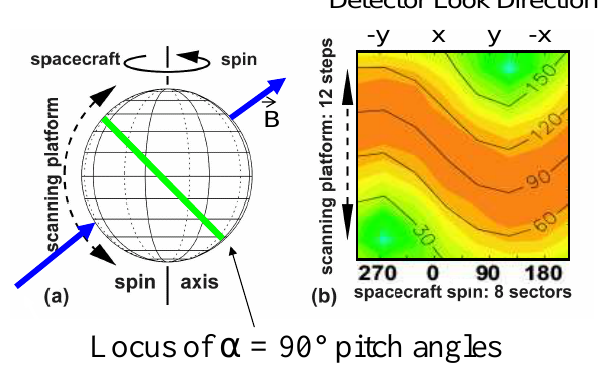
Fig. 2. This figure demonstrates how one interprets Figs. 3–5. The detector scans through the unit sphere in 36s (left) and the fluxes are linearly translated from elevation and azimuth onto an orthogonal Cartesian coordinate system (right). The green line corresponds to the locus of all 90 ◦ pitch angles. The blue arrow is the magnetic field vector, where it points from the center of the 30 ◦ contour to the center of the 150 ◦